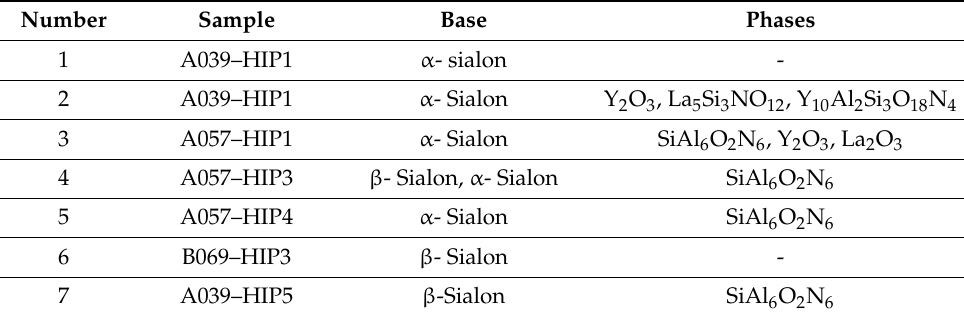
Table 4. Chemical compositions obtained in